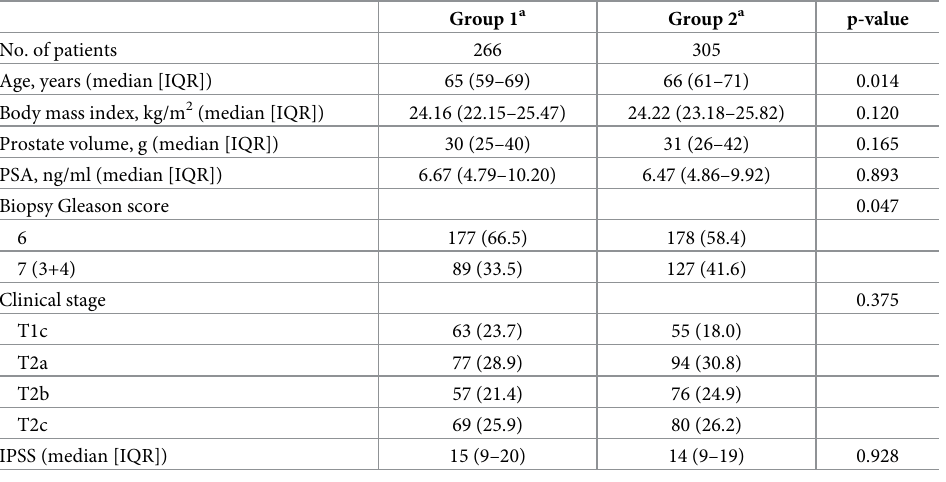
Table 1. Patients’ characteristics.